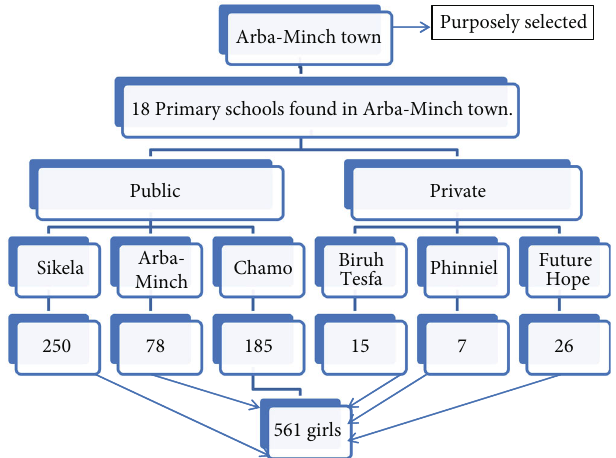
Figure 1: Sampling procedures to select study units from primary schools in Arba Minch town, Southern Ethiopia, January,